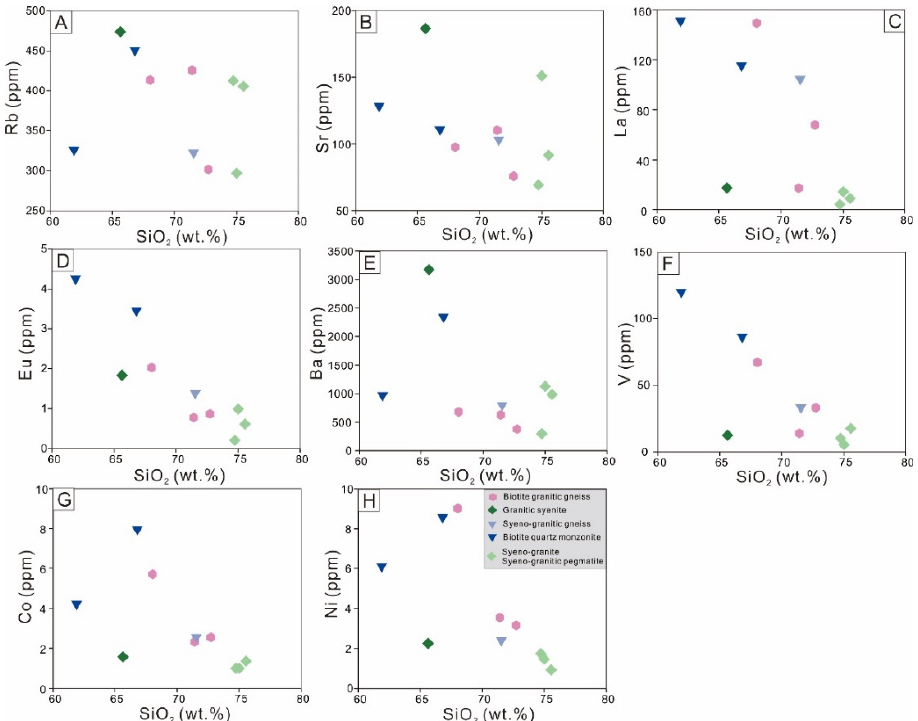
Figure 9. ( A – H ) SiO 2 vs. selected trace elements showing variation trends of biotite granitic gneiss, syeno-granite, syeno-granitic pegmatite, granitic syenite, syeno-granitic gneiss, and biotite quartz monzonite.